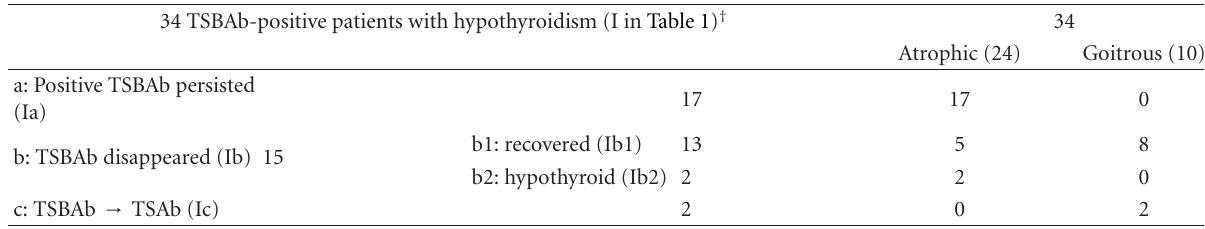
Table 3: Atrophic autoimmune thyroiditis or goitrous autoimmune thyroiditis in the 34 TSBAb (TSH-stimulation-blocking-antibody)- positive patients with hypothyroidism (a) and recovery from hypothyroidism